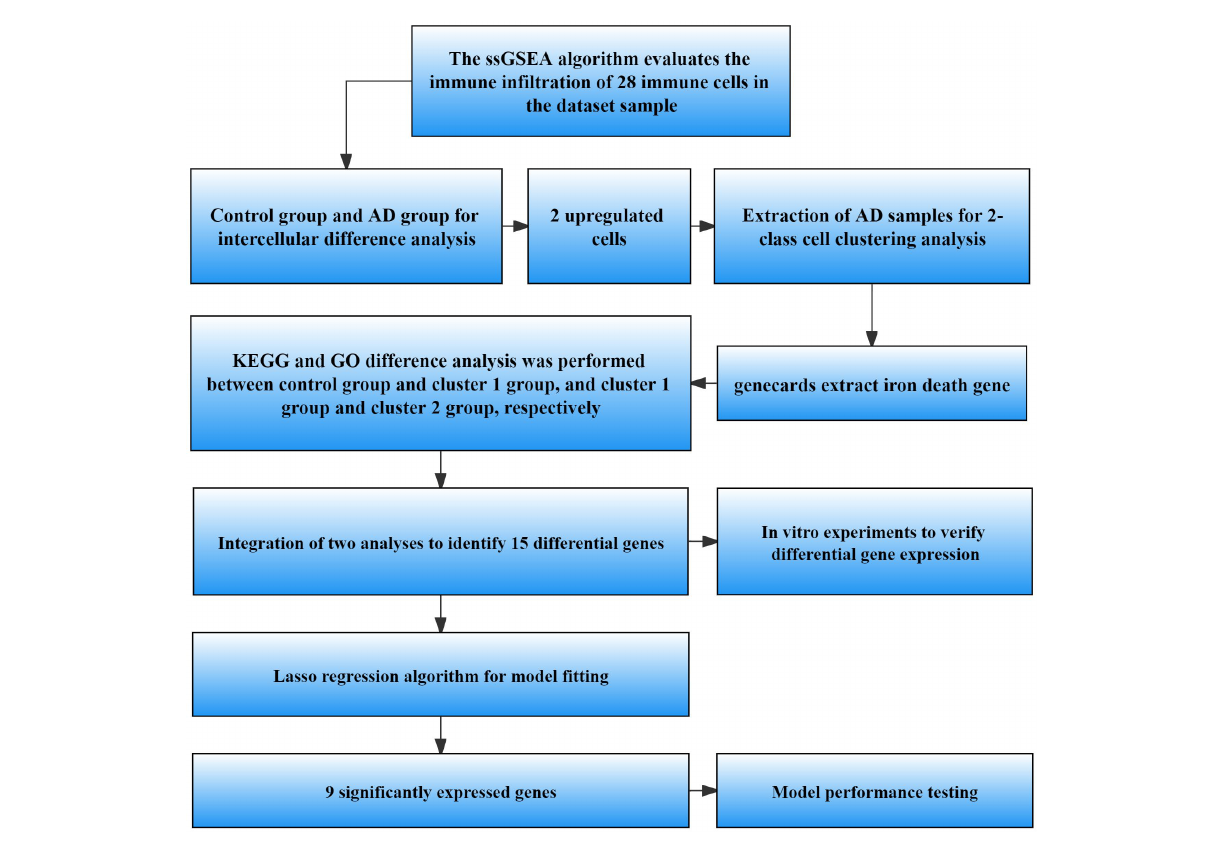
FIGURE 1 Flow chart of data processing and analysis. ssGSEA, Single sample gene set enrichment analysis; AD, Alzheimer’s disease; GO, Gene ontology; KEGG, Kyoto Encyclopedia of Genes and Genomes; LASSO, Least absolute shrinkage and selection